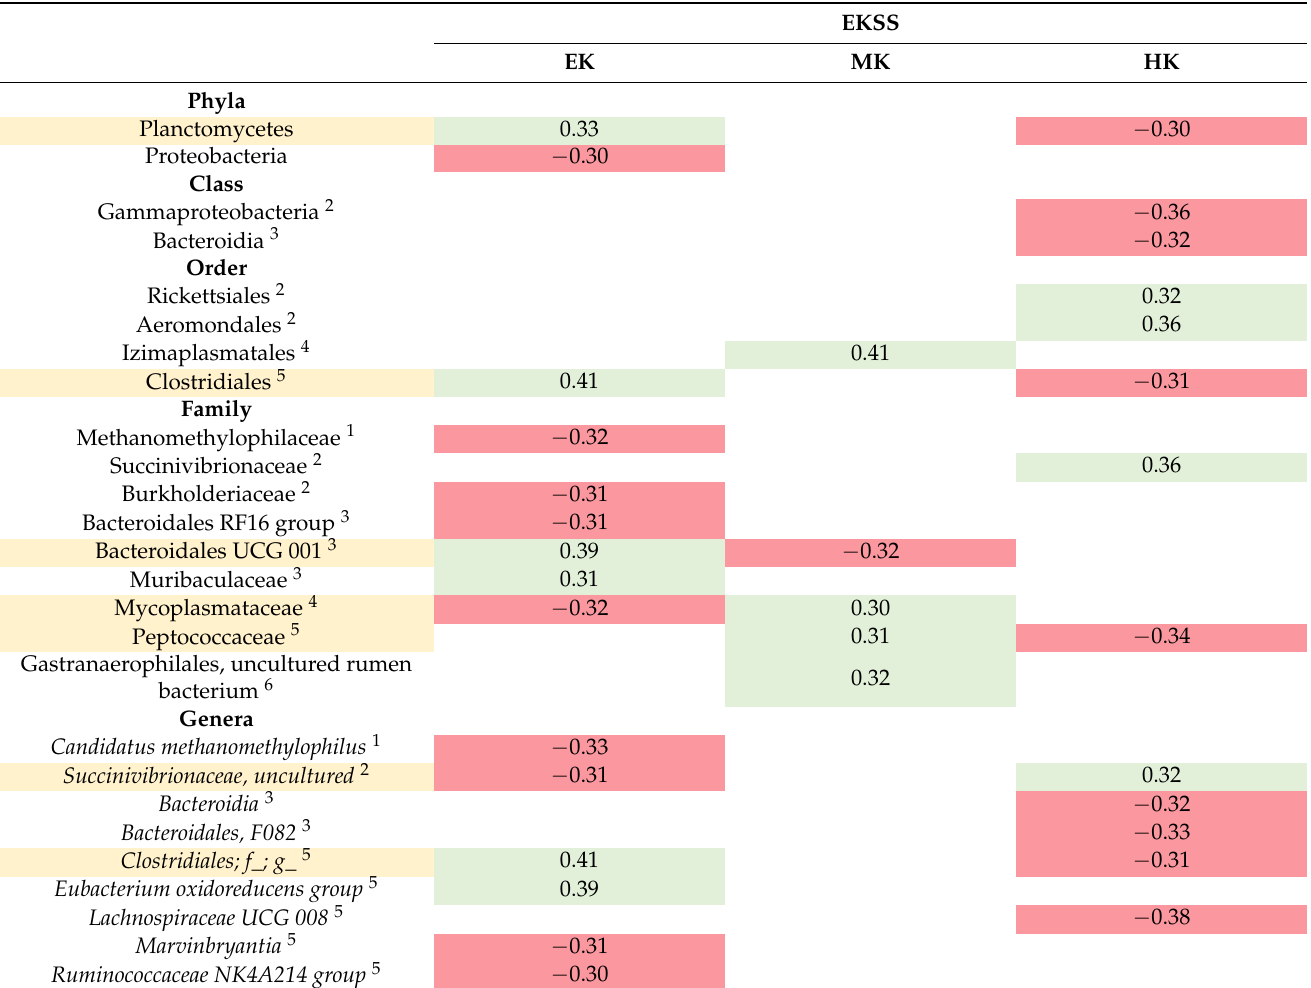
Table 5. Spearman